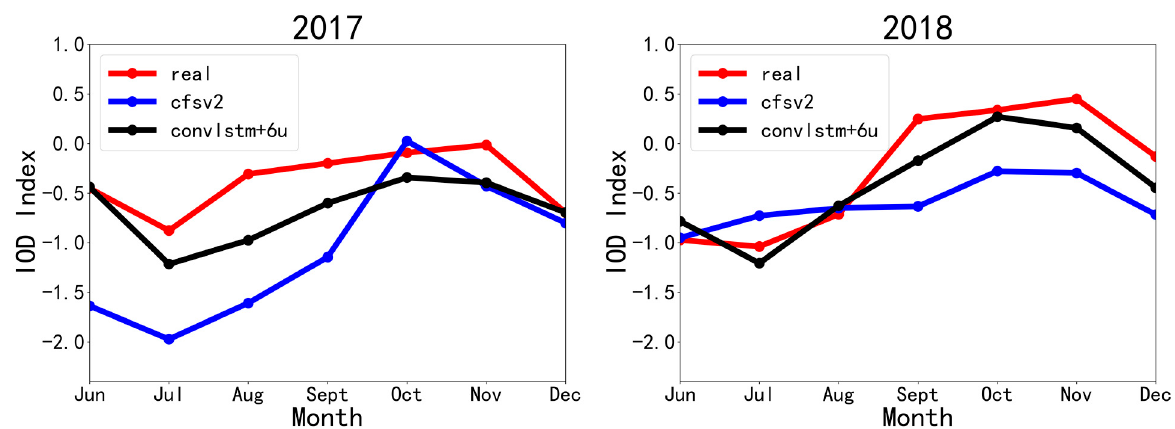
Figure 5. The IOD index of the convLSTM model with wind field data before 6 month and the index of the CFSv2 model from 2015 to 2018.